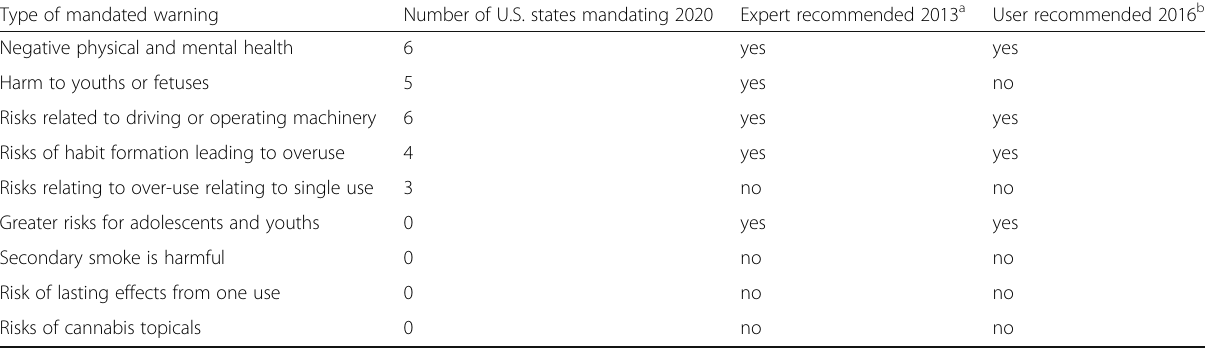
Table 3 Mandated types of warnings compared to the types of warnings recommended by cannabis experts and types of warnings receommended by a group of cannabis